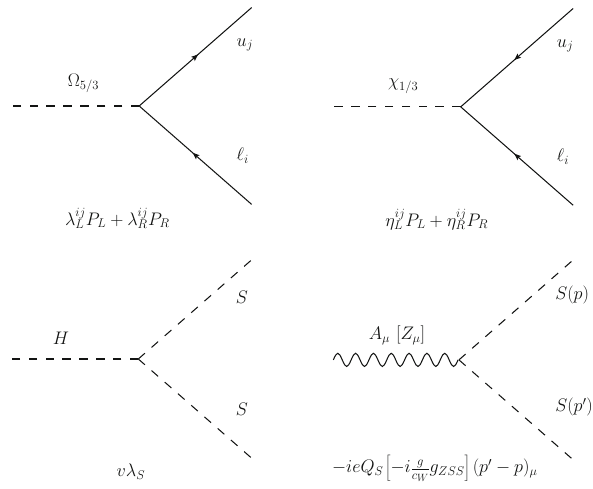
Fig. 1 Feynman rules necessary for the calculation of the contribution of the scalar LQ Ω 5 / 3 to the t → cX ( X = γ, Z , H ) decays. For completeness we also include the Feynman rules for the LQ singlet χ 1 / 3 of the model discussed in [21] as our results are also valid for its contribution, thus S stands for Ω 5 / 3 and χ 1 / 3 , with g ZSS = 1 ( − 2 ) for S = Ω χ 10 s 2 s 2 1 / 3 5 / 3 ( W W 3 3